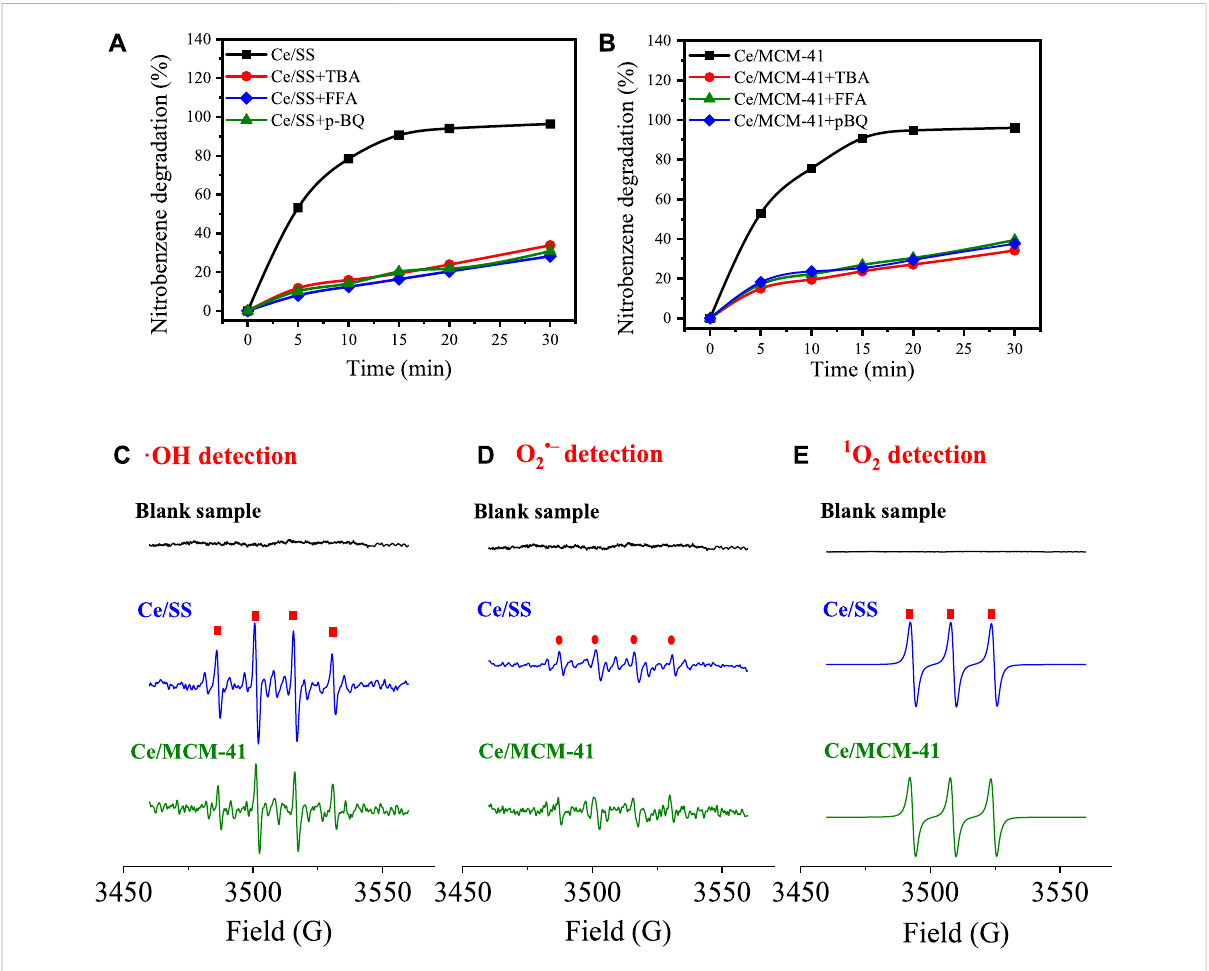
FIGURE 5 Radical quenching tests for catalytic ozonation using Ce/SS (A) and Ce/MCM-41 (B) ; In situ EPR spectra for · OH (C) , O 2 identi fi cation in Ce/SS- and Ce/MCM-41- driven COPs.